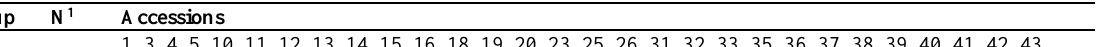
Table 2 . Grouping of 323 accessions of C. canephora by the Tocher optimization method, based on the Standardized Average Euclidean Distance matrix and 38 characters evaluated in the Germplasm Active Bank, Experimental Farm of Bananal do Norte,